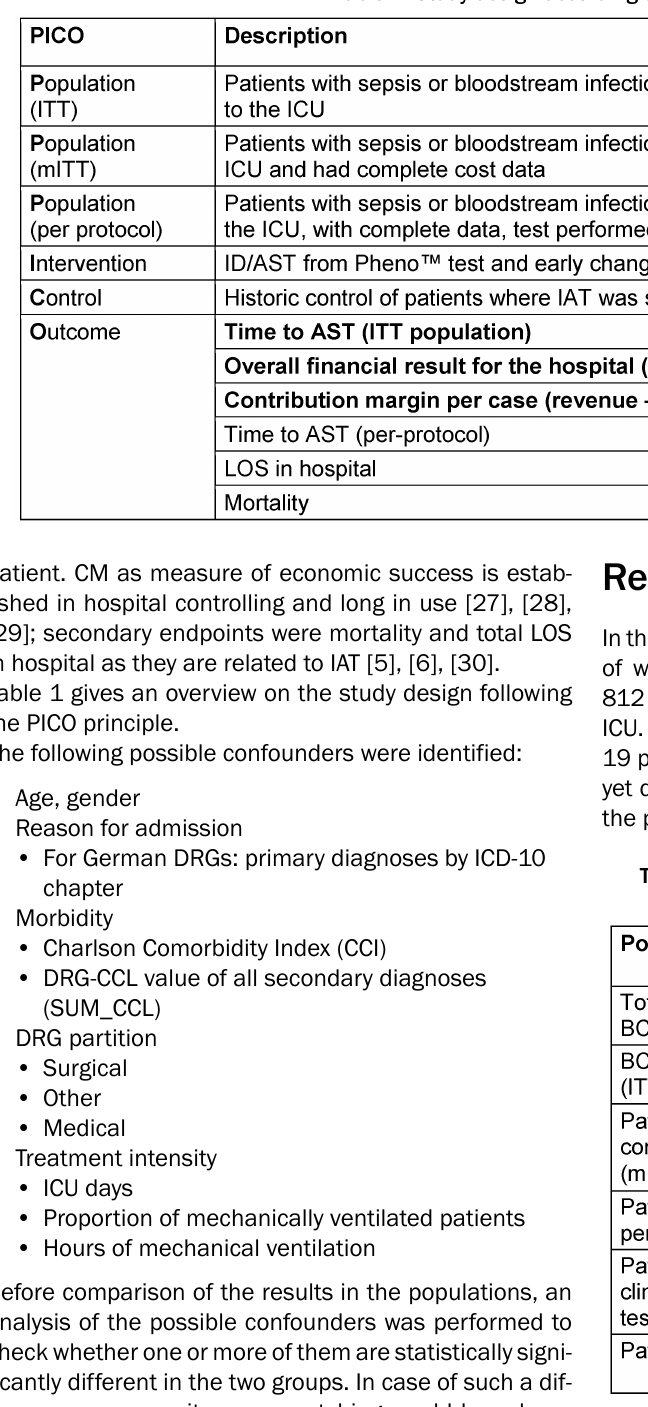
Table 1: Study design according to the PICO principle